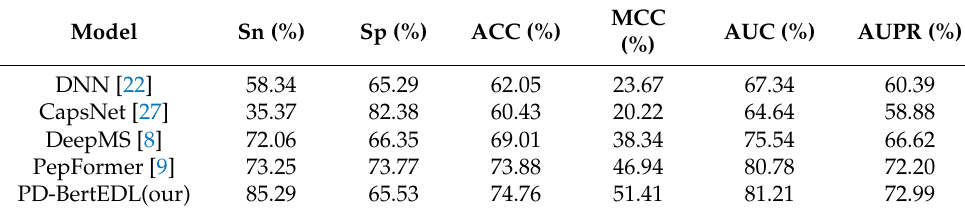
Table 6. The results of PD-BertEDL and other predictors on the independent test set of Musculus